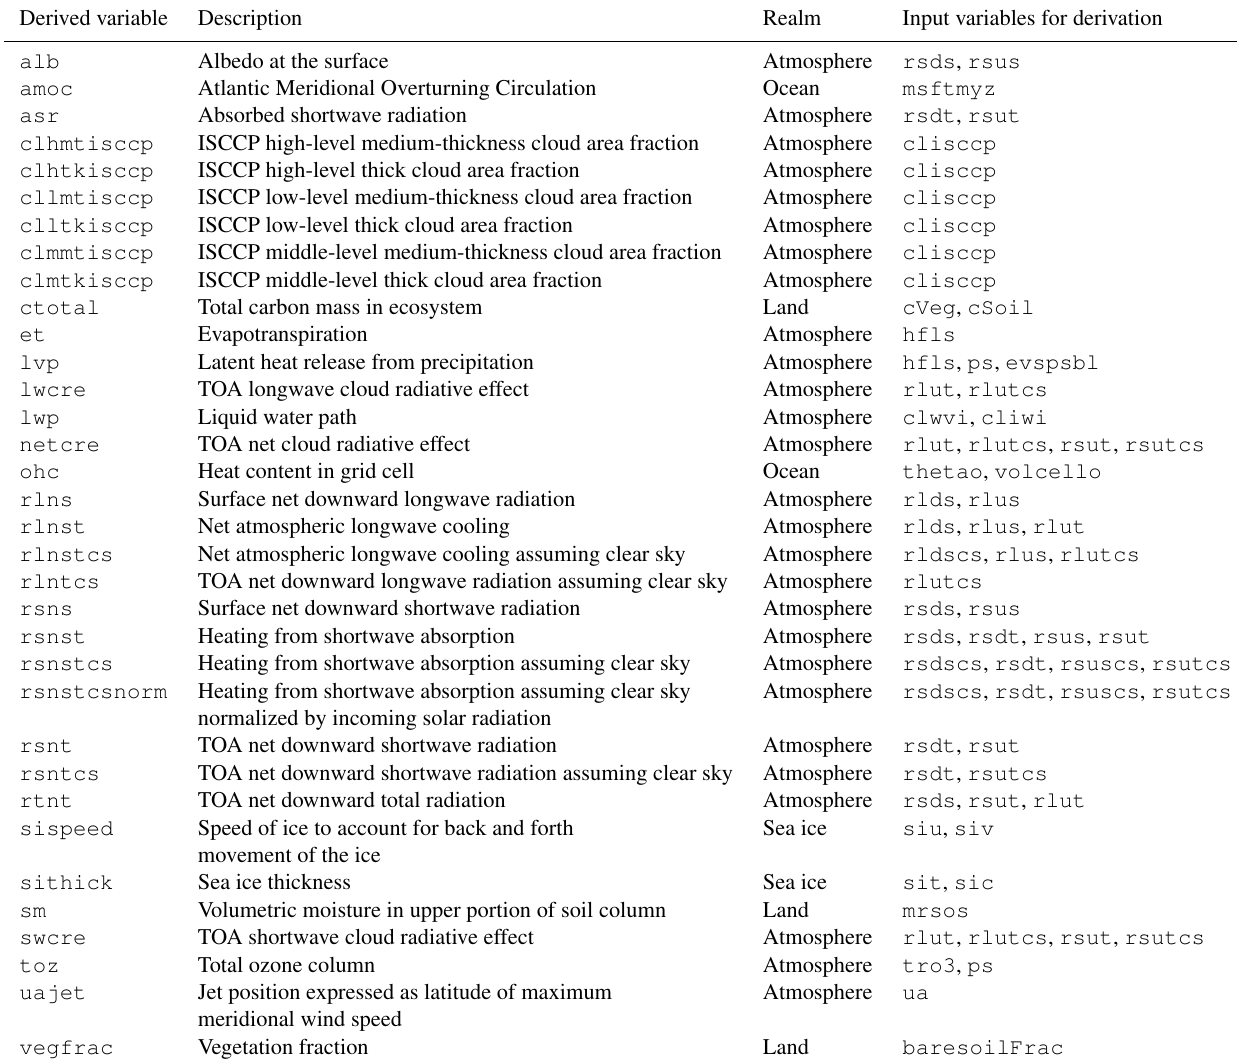
Table 2. List of variables for which derivation algorithms are available in ESMValTool v2.0 and the corresponding input variables. ISCCP is the International Satellite Cloud Climatology Project; TOA means top of the